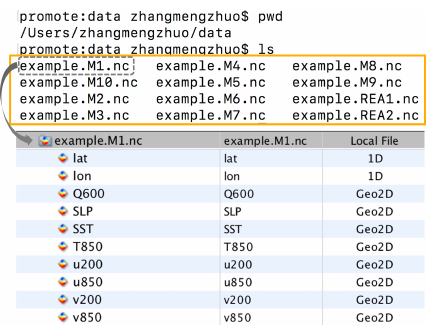
Figure 3. Example of data preparation for the MVIETool. There are eight variables stored in each data file: Q600, SLP, SST, T850, u200, u850, v200, v850. Variables u850 (u200) and v850 (v200) compose an individual 2-D vector variable – uv850 (uv200), and the other four variables are regarded as scalar variables. REA1 and REA2 are two sets of reanalysis data used in the